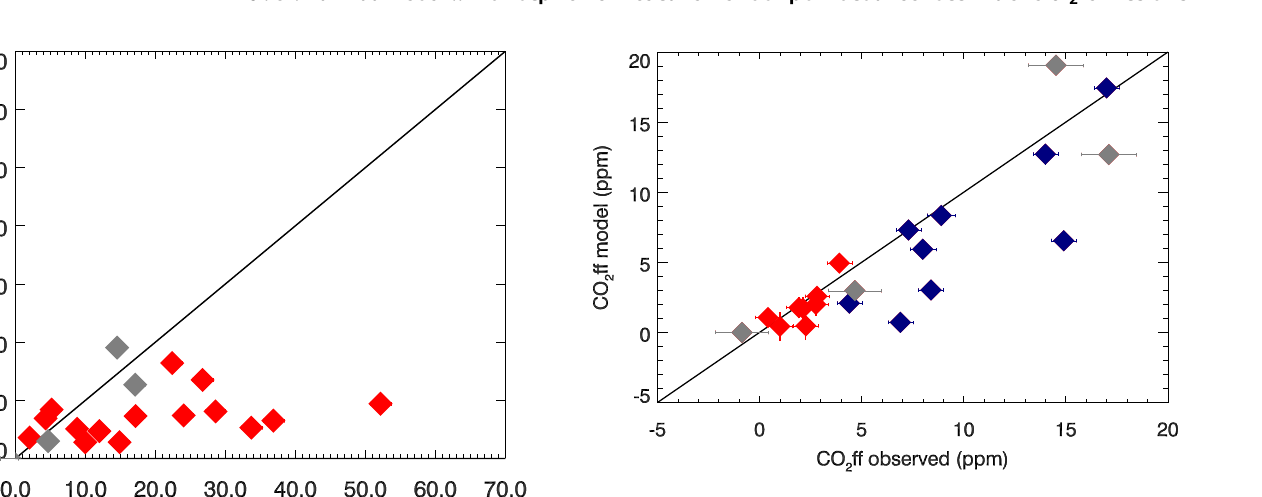
Figure 8. Comparison of observed and modeled CO 2 ff from the August (red) and October (blue) grass samples, and 26 October sur- face flasks (grey). The 1:1 line is shown in